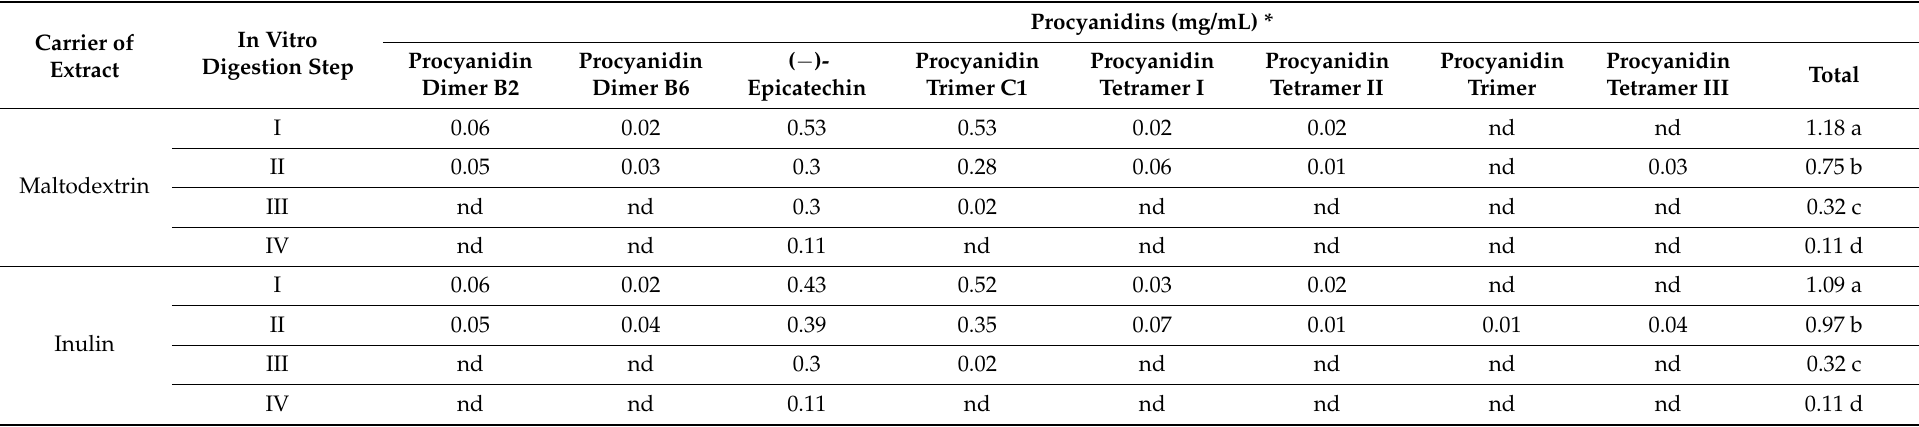
* Values with different letters were significantly different at p = 0.05 according to Duncan’s test. Values were converted into daidzein (daidzin and malonyldaidzin) or genistein (glycitin, genistin, malonylglycitin, malonylgenistin isomer and malonylgenistein). Abbreviations: I—liquid after simulated saliva digestion; II—liquid after gastric fluid digestion; III—liquid after simulated intestinal fluid digestion; IV—liquid after membrane; nd—not detected. Table 2. Concentration on polyphenolic compounds (mg/mL) of liquids released during in vitro digestion of wheat bread enriched with hawthorn extracts (HtM, HtI). In Carrier of Extract